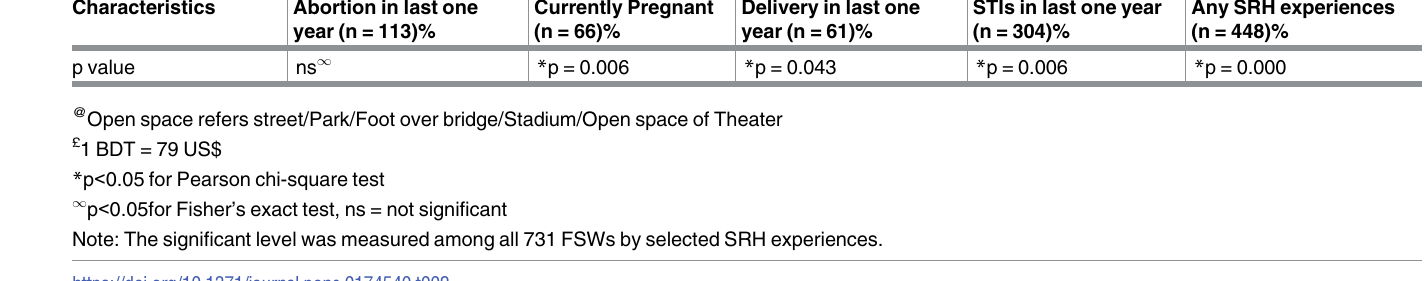
PLOS ONE | https://doi.org/10.1371/journal.pone.0174540 April 3,